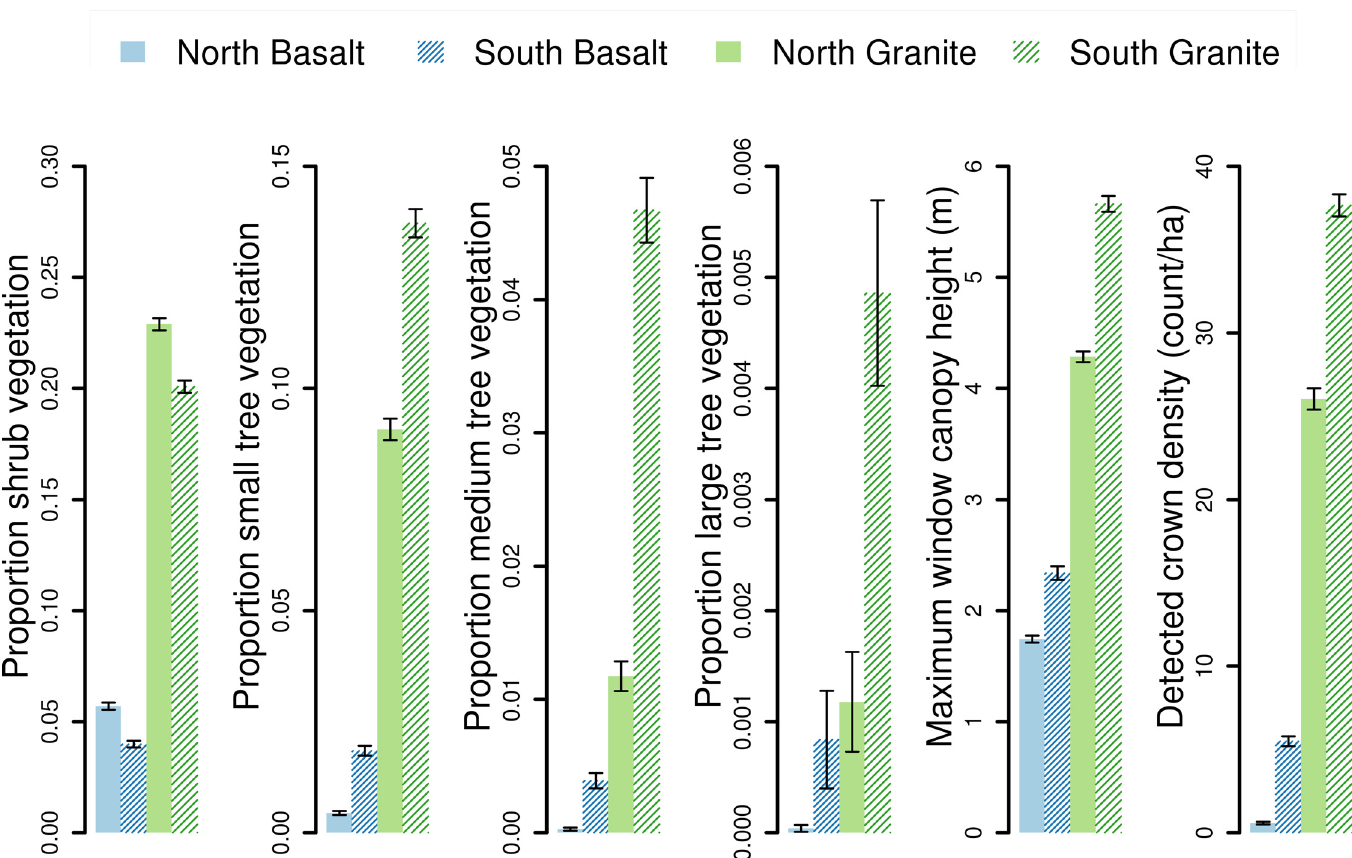
Fig 2. Mean values of the vegetation structure metrics for the four watersheds. The mean and 95% confidence interval for each of the six vegetation structure metrics across 5000 randomly located samples selected from each watershed (without stratification). The vegetation structure within the four watersheds can differ by an order of magnitude. Proportion vegetation is defined as the proportion of area in a 16.8 x 16.8 m window of the vegetation height map that is in the given height class: 0.5 to 2.5 m (shrub), 2.5 to 5.0 m (small tree), 5.0 to 10.0 m (medium tree), and > 10.0 m (large tree).